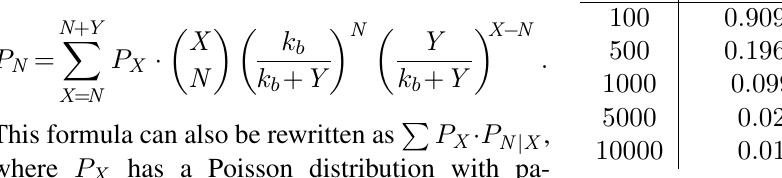
TABLE II: The approximate value (12) against simulated estimates of the mean and variance in the large Y